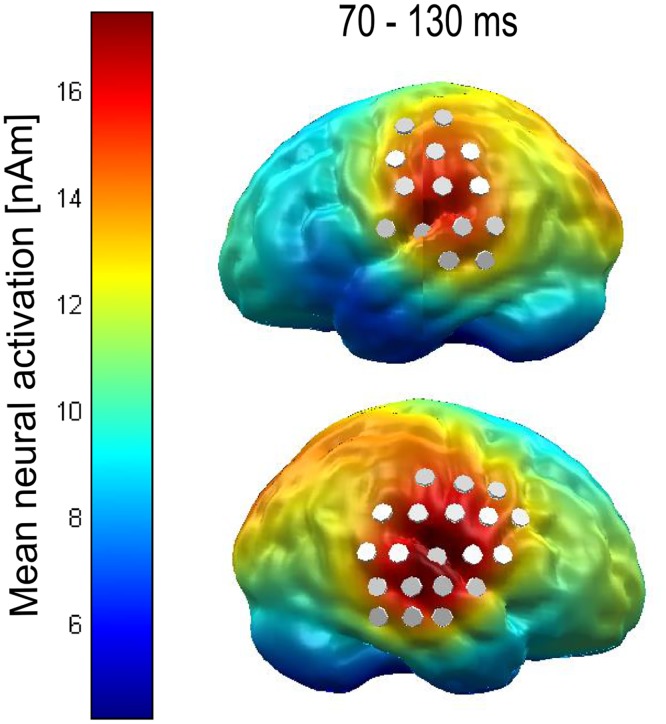
Depiction of the dipoles chosen as the auditory region of interest (ROI).Mean neural activation for the TT over all conditions was averaged between 70 and 130 ms and plotted on a cortical surface. Grey cylinders indicate the locations of selected dipoles.